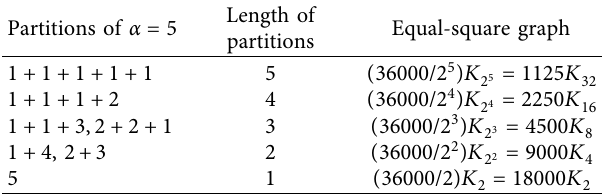
Table 2: Equal-square graphs of small-order groups. Order Groups